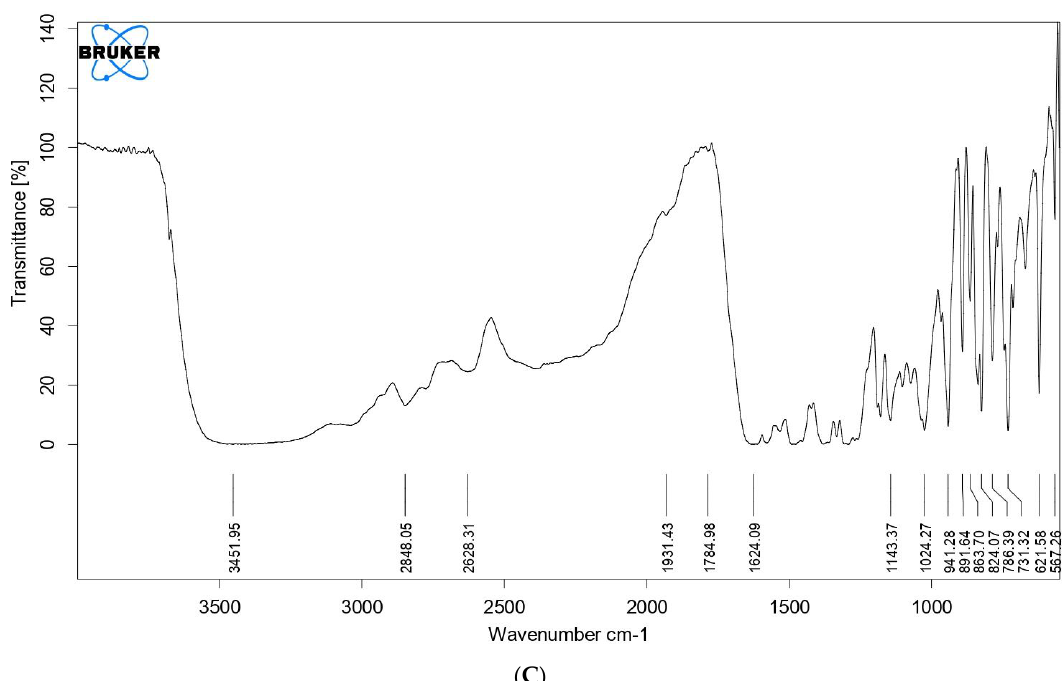
Figure 6. FTIR with characteristics peaks of ( A ) β -TCP ( B ) Pure drug ( C ) Nanocarriers’ formulation.